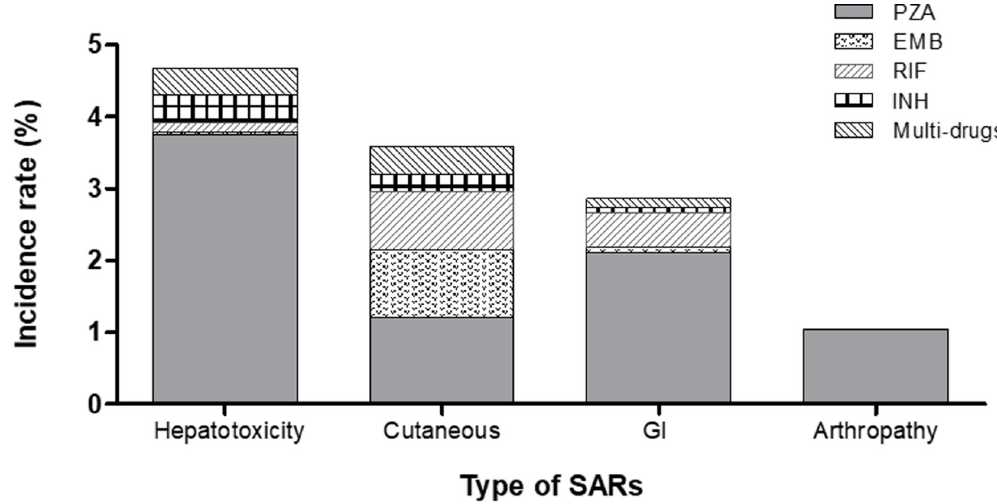
Fig 2. The proportion of each anti-tuberculosis drug related to severe adverse events.